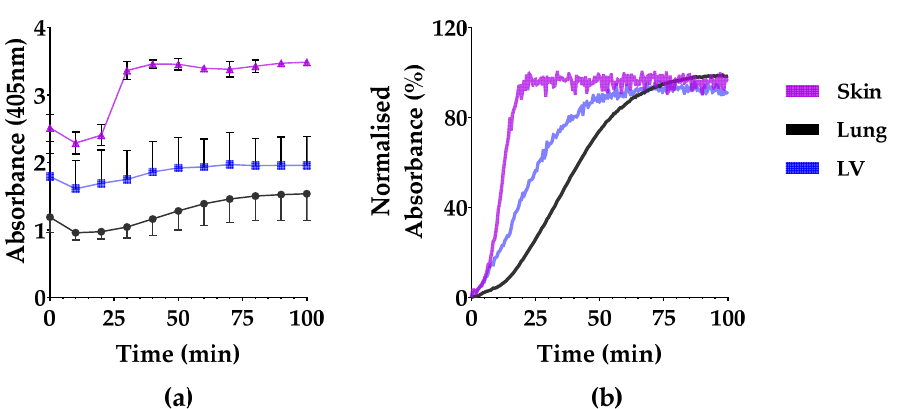
Figure 2. Turbidity of skin-ECM, lung-ECM and LV-ECM hydrogels. ( a ) Turbidity data (mean and S.D.) at every 10 min; ( b ) Normalized absorbance from the start of gelation. All data derived from a minimum of three independent experiments performed in triplicates. Data are presented as mean with SD.